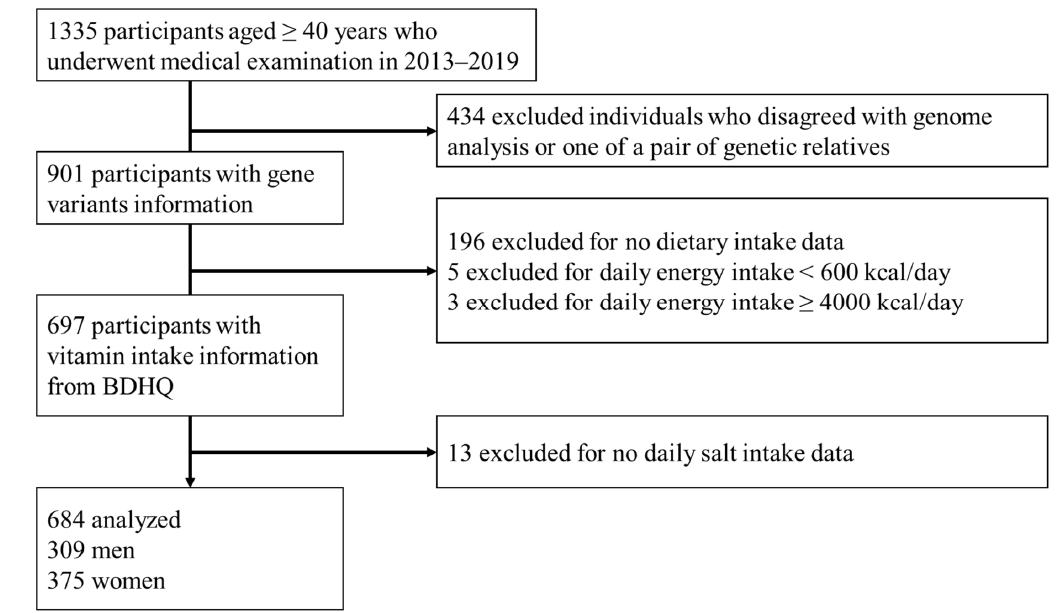
Figure 1. Flow chart showing the study enrolment procedure.